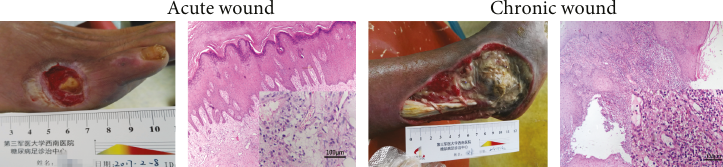
Figure 1: The condition of the diabetic foot wound and the in fl ammatory cellular in fi ltration (HE staining, × 200).